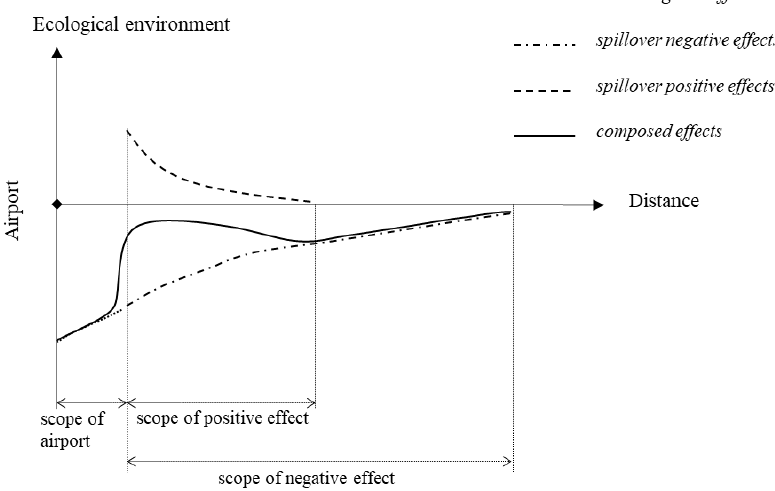
Figure 2. Theoretical curve of the impact of an airport on the surrounding ecological environment